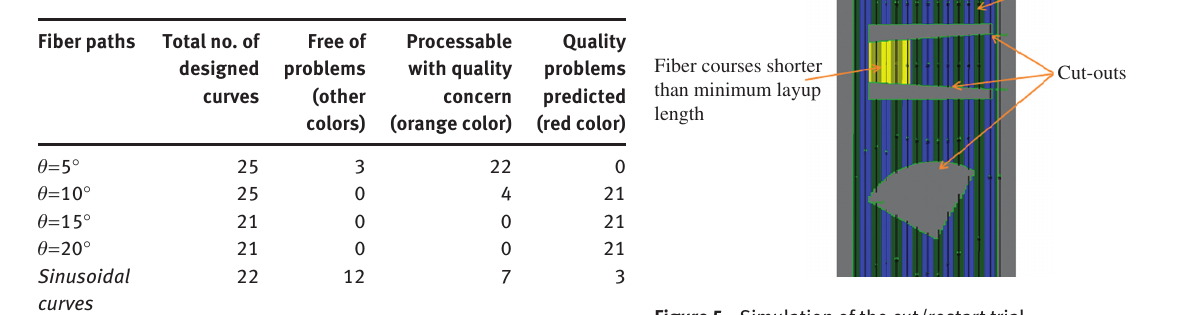
Figure 5 Simulation of the cut/restart